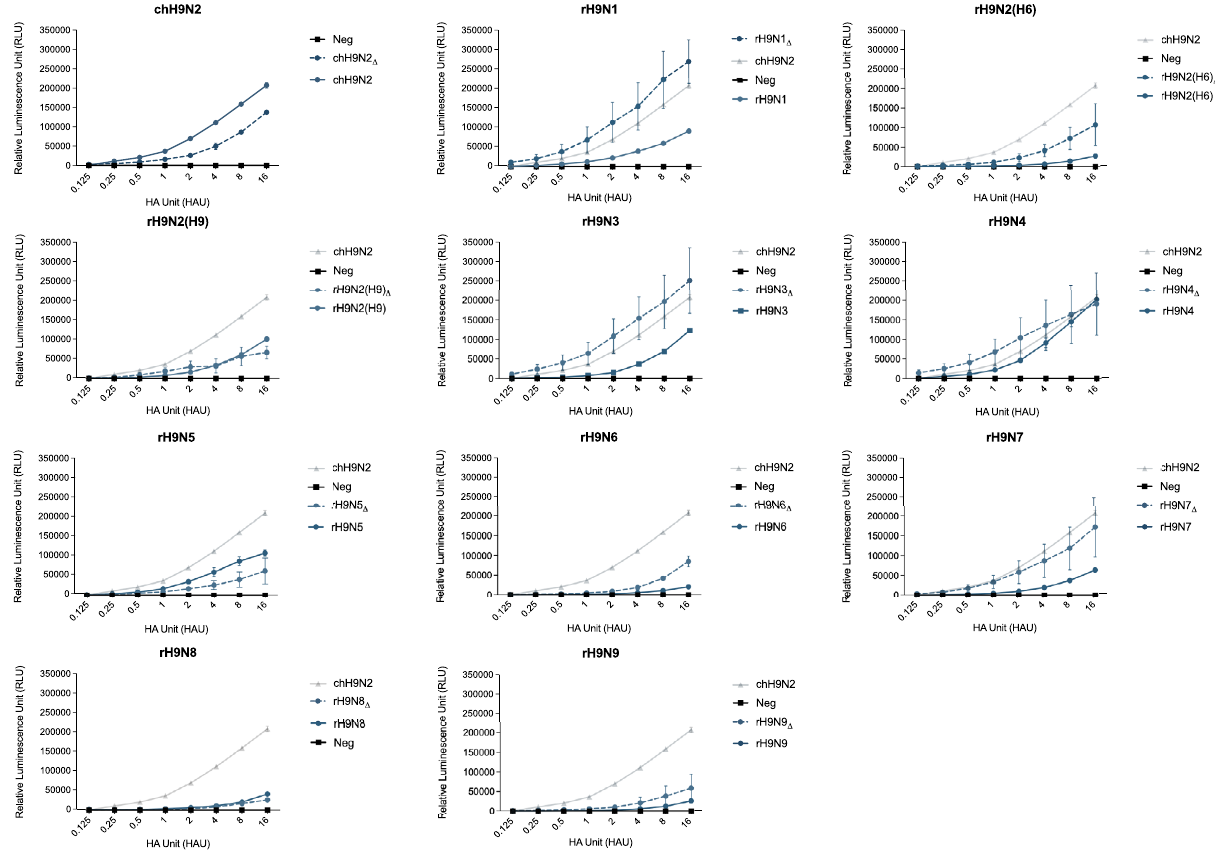
Figure 4. NA activity of the rH9Nx reassortants with and without a 20 aminoacid stalk deletion. Graph demonstrates the Relative Luminescence Unit at given HAU titers. Errorbars represent the standard error of the mean